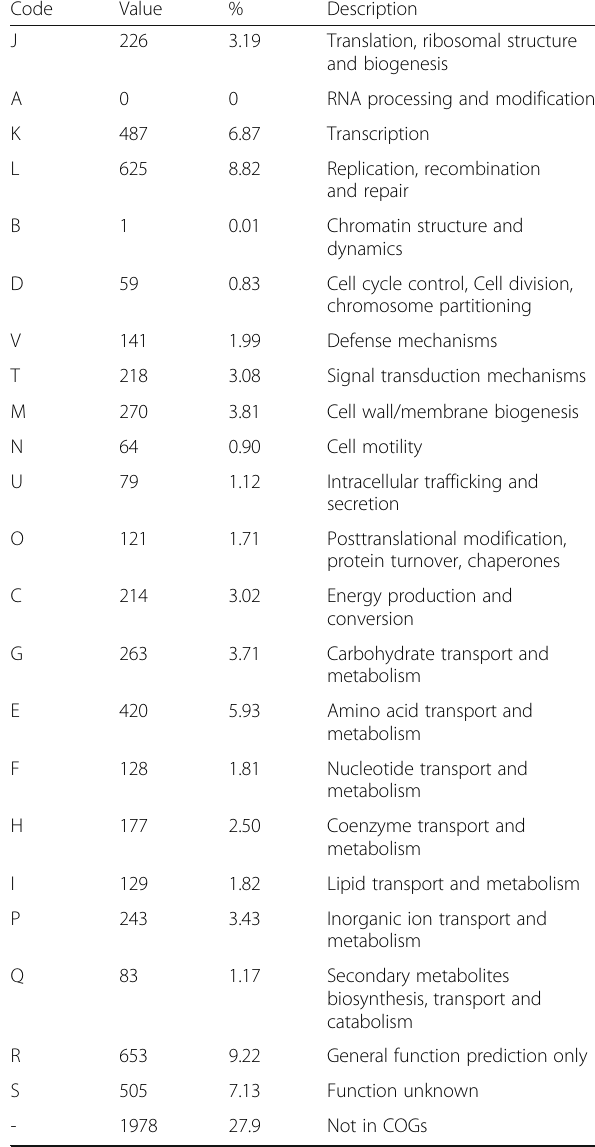
Table 5 Number of protein encoding genes associated with general COG functional